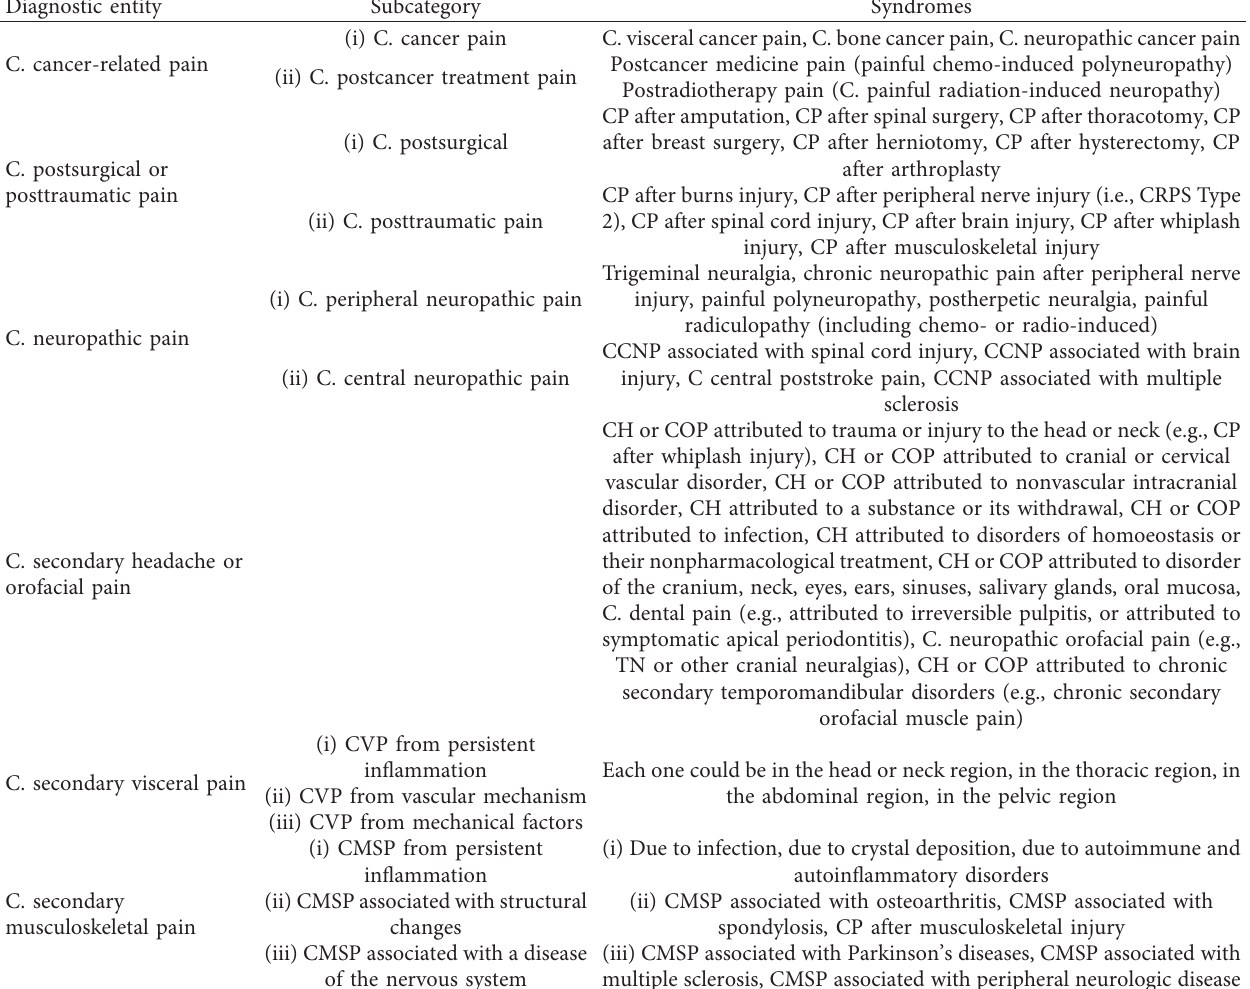
Table 2: Classification of chronic secondary pain syndromes [3, 4].